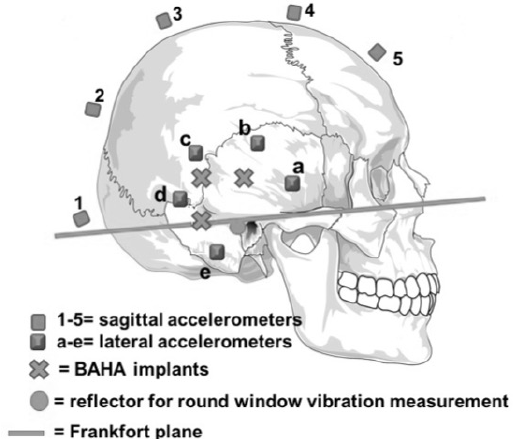
Figure 2. Positions of the three BAHA TM implants (crosses), the five accelerometers set along the sagittal line (1–5), the five accelerometers set around each ear (a–e), the reflector deposited on the round window for use with the laser velocimeter (disk) and the Frankfort plane (straight line). The implants were fixed in the bone with a measured strength of 45 Newtons. Fifteen linear accelerometers (Bruel and Kjaer 45–17c, Naerum, Denmark) were installed: Five accelerometers were placed at equal distance on the sagittal midline from frontal to occip- ital, one beside each BAHA™ implant (three on each side) and one in each of the spaces available between the implants (two on each side). To fix all the accelerometers, we ex- posed the bone by dissecting five squares of soft tissue (2 × 2 cm). The accelerometers were glued directly on the bone for optimal data monitoring. Linear accelerometers, which measure acceleration in only one direction, were used to measure the linear vibration passing through them in the coronal plane from the emitting ear to the other ear. To avoid any damping of the vibrations by external contact and to maintain the head in an upright fixed known position for the duration of the experiment, a stake was placed through the medullar canal of the remaining cervical vertebrae. The microscope, head, and laser were all placed on anti-vibration tables in an anechoic chamber (Figure 3).